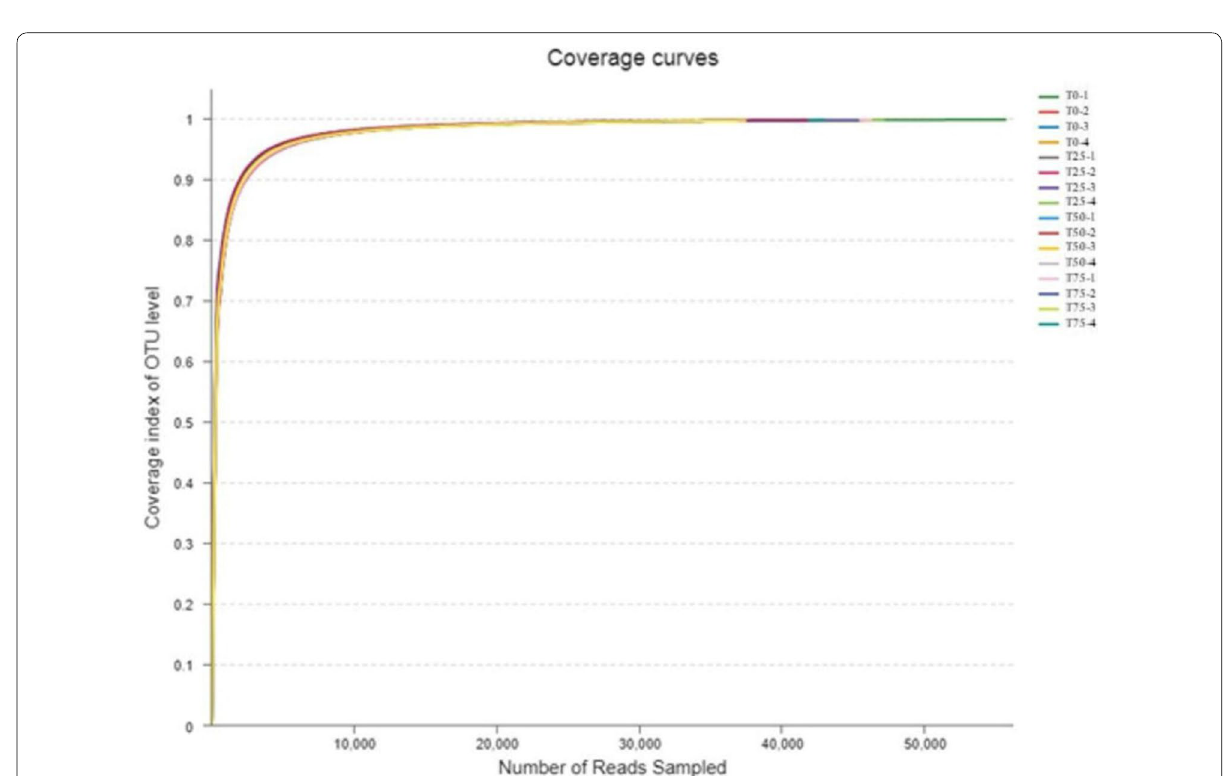
Fig. 3 Coverage curves of feces